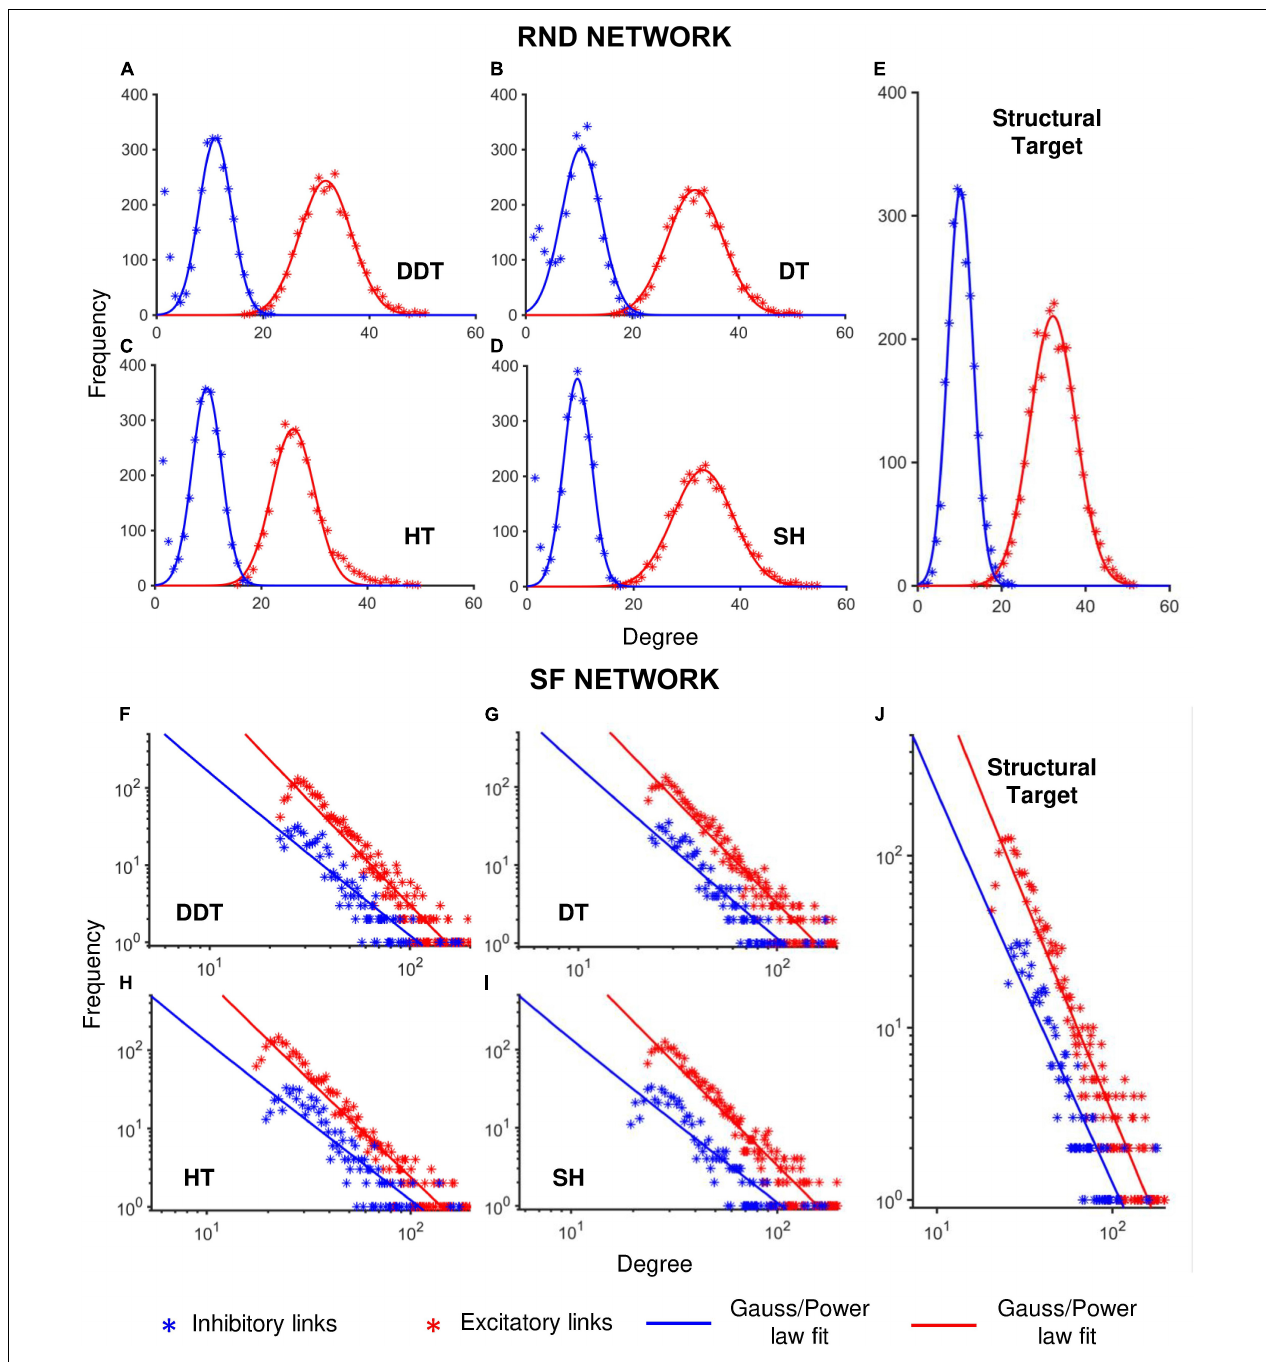
FIGURE 4 | Degree distribution of RND and SF networks as a function of the different thresholding methods. Each panel shows the cumulative degree distributions evaluated over n = 6 simulations, considering separately the excitatory (red) and inhibitory (blue) subnetworks. (A–D) Degree distributions of RND networks thresholded with DDT, DT, HT and SH methods, respectively. (E) Structural degree distribution of the randomly connected excitatory and inhibitory sub-populations. (F–I) Degree distribution of SF networks thresholded by DDT, DT, HT, and SH methods, respectively. (J) Structural degree distribution of the SF excitatory and inhibitory sub-populations. * p < 0.05, ** p <